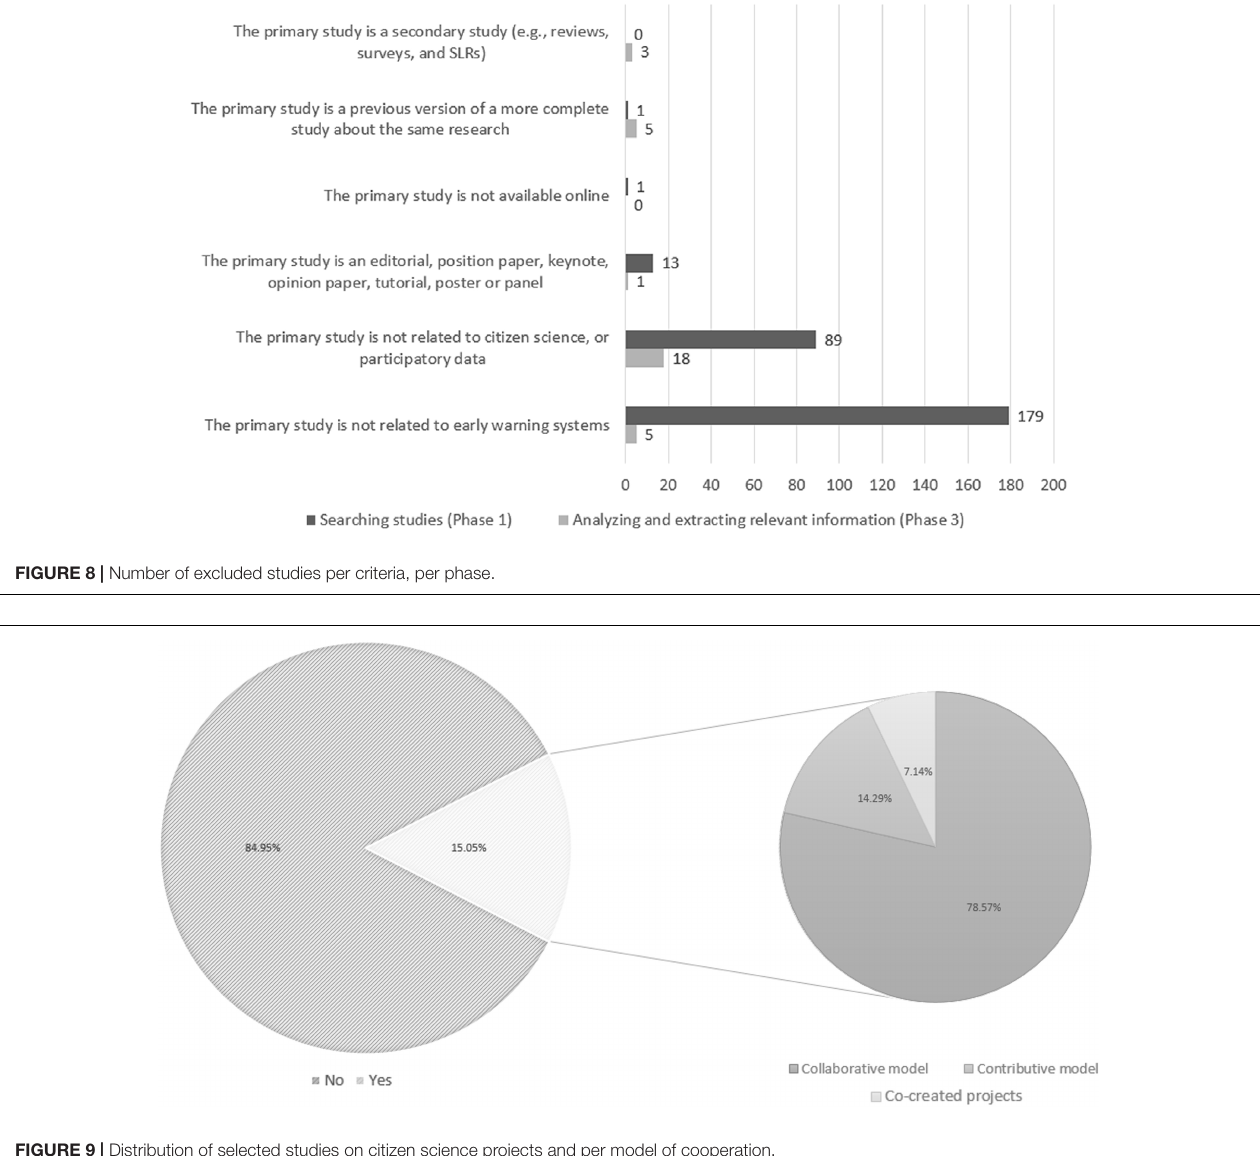
FIGURE 9 | Distribution of selected studies on citizen science projects and per model of